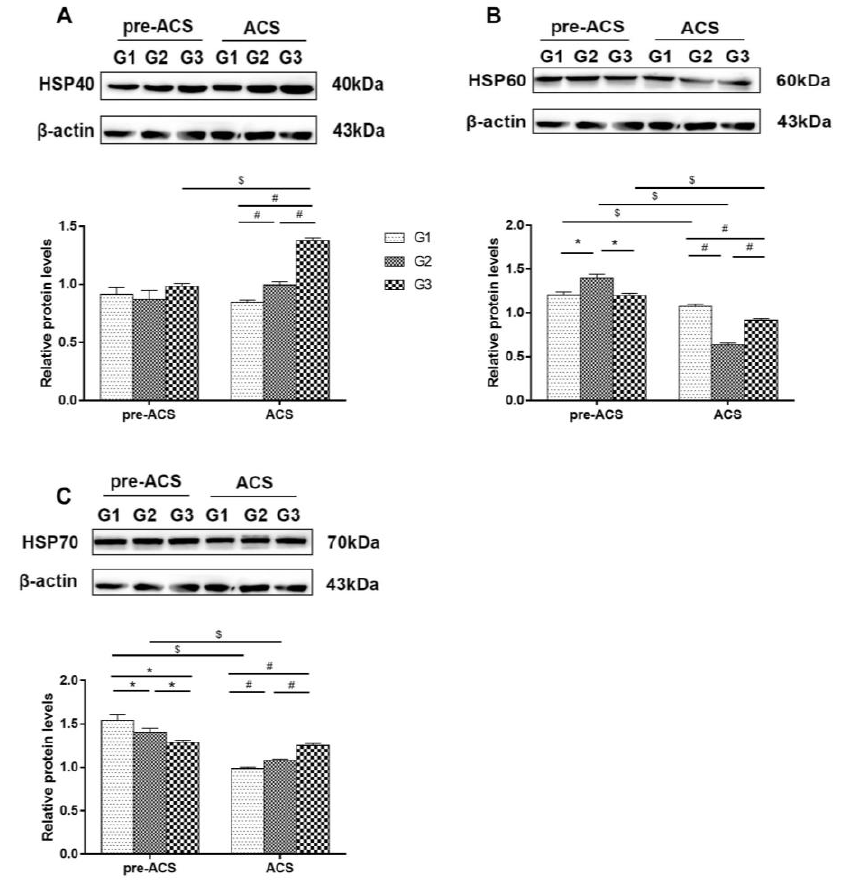
Figure 7. The protein levels of heat shock proteins HSP40 ( A ), HSP60 ( B ), and HSP70 ( C ) in ilea of broilers before and after ACS. Data were presented as mean ± SD ( n = 6). Different labels represent significant differences ( p < 0.05). pre-ACS (*), ACS (#) and before and after ACS ($). G1, cold stimulation for 0 h; G2, cold stimulation for 3 h; G3, cold stimulation for 6 h. The original protein images of HSP40 , HSP60 , HSP70 , and β -actin are shown in Figures